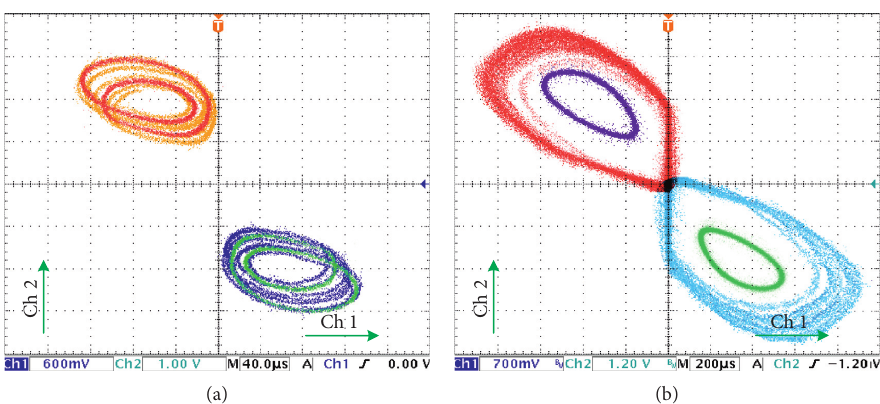
Figure 11: Experimentally captured trajectories in the v period-6 for R 2 � 5.57k Ω and L � 10 mH. (b) Coexisting limit cycle with period-1 and single-scroll chaotic attractors for R 2 � 4k Ω and L � 87.24